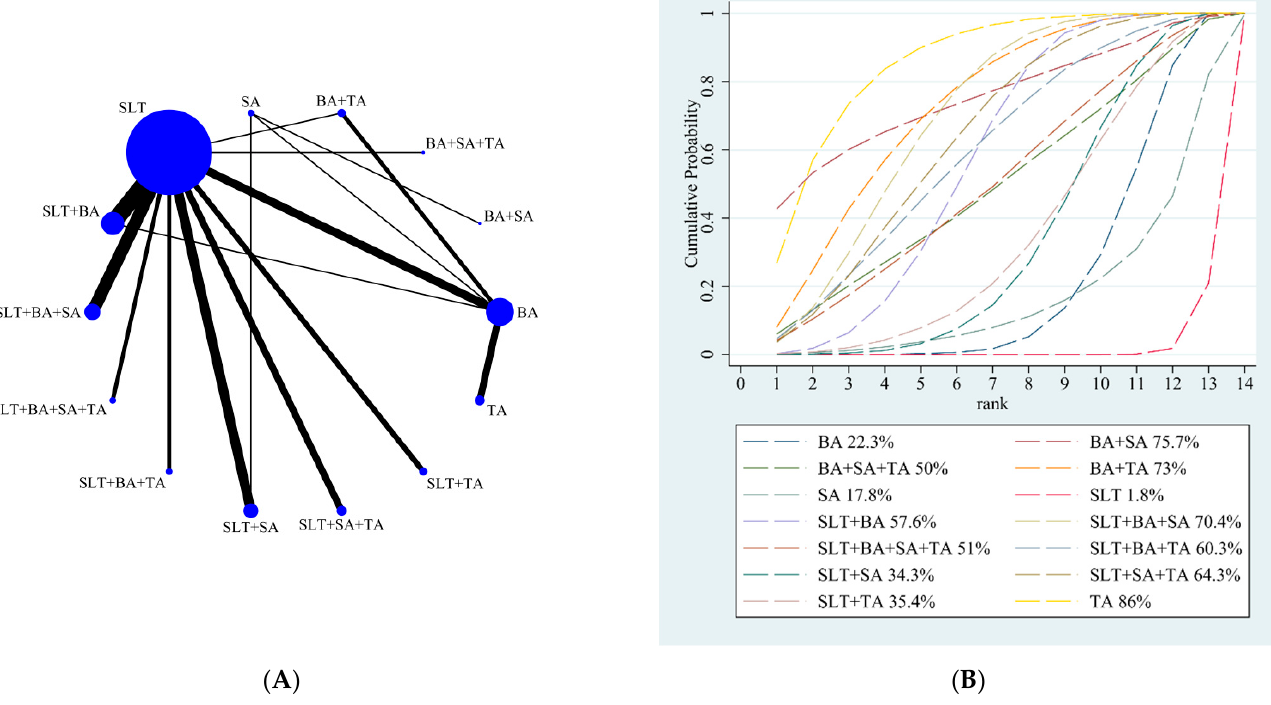
Figure 2. ( A ) NMA figure for total effective rate. ( B ). SUCRA plot for total effective rate.